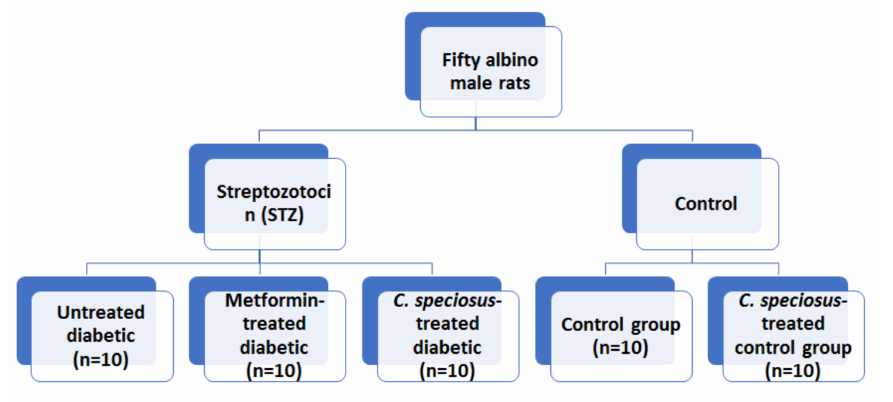
Figure 1. Graphical scheme of the study